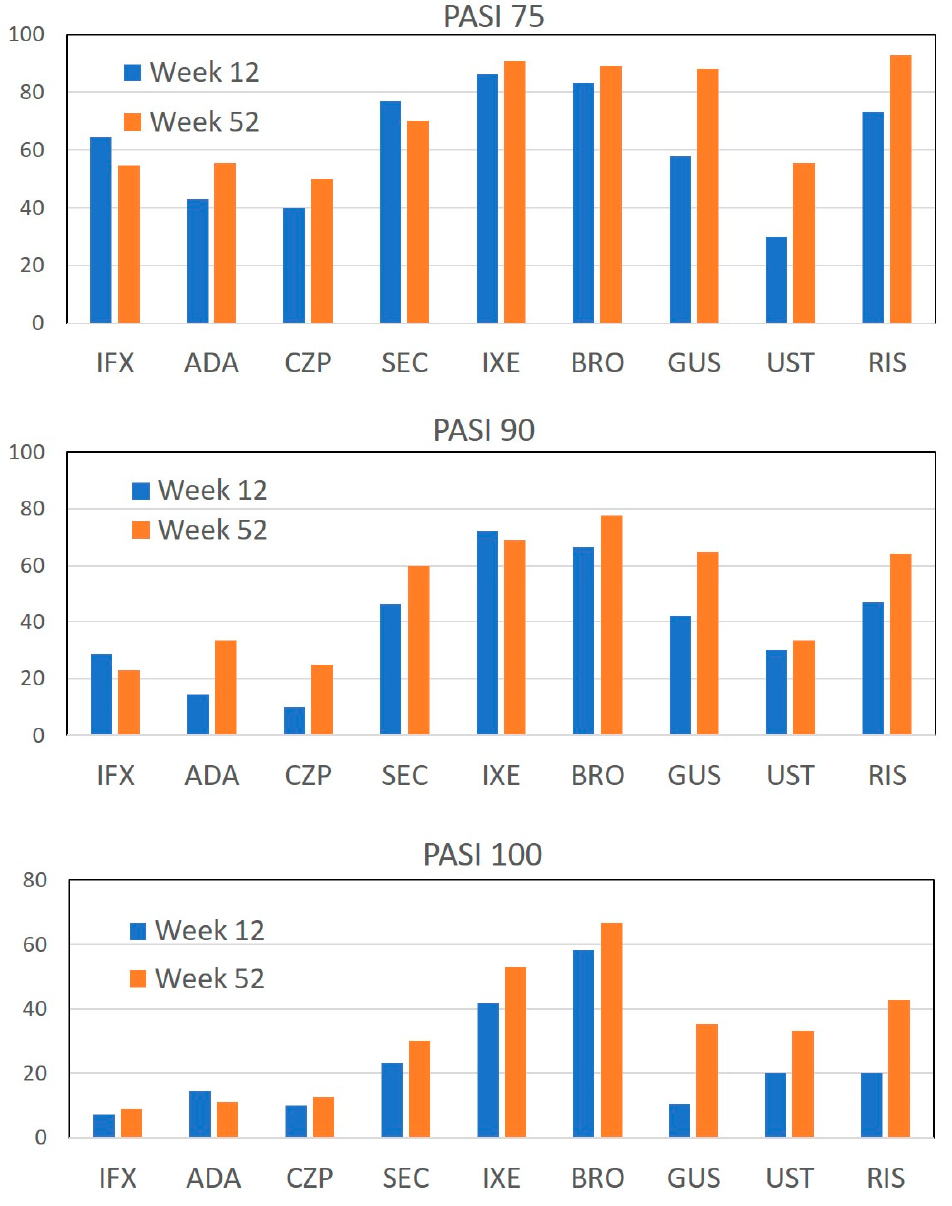
Figure 1. The achievement rates of psoriasis area and severity index (PASI) 75, 90, and 100 at week 12 and 52 of treatment with individual biologics in patients with psoriasis. IFX, infliximab; ADA, adalimumab; CZP, certolizumab pegol; SEC, secukinumab; IXE, ixekizumab; BRO, brodalumab; GUS, guselkumab; UST, ustekinumab; RIS, Risankizumab.